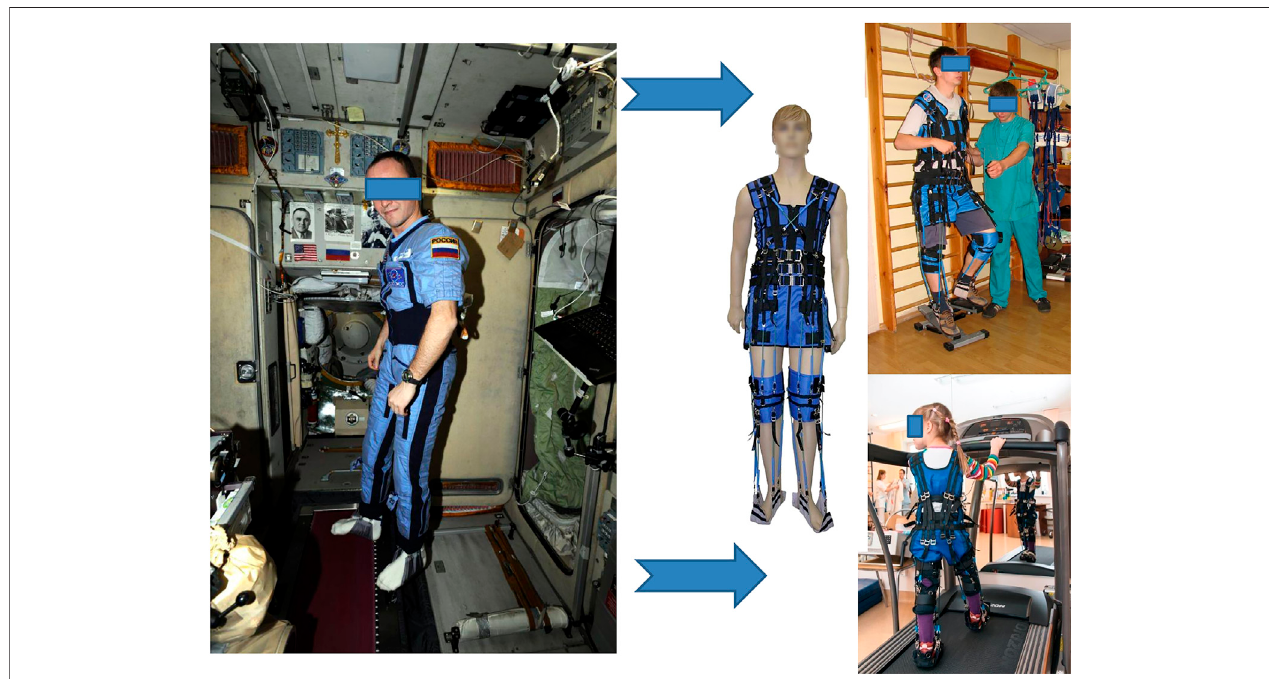
FIGURE 1 | Axial loading suit. On the left —“ Penguin ” space suit and its application on board the International Space Station; on the right – its clinical version “ Regent ” (Center of Aerospace Medicine and Technologies, Russia) and its adaptation for rehabilitation of adult patients and children. Photo credit IBMP